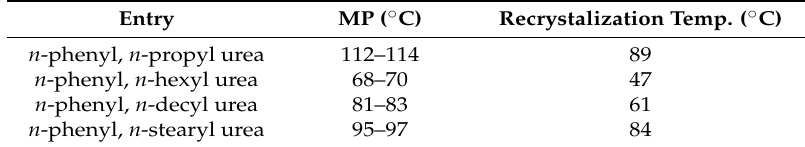
Table 2. n -Phenyl, n -alkyl urea melting points and crystallization temperatures determine from DSC.